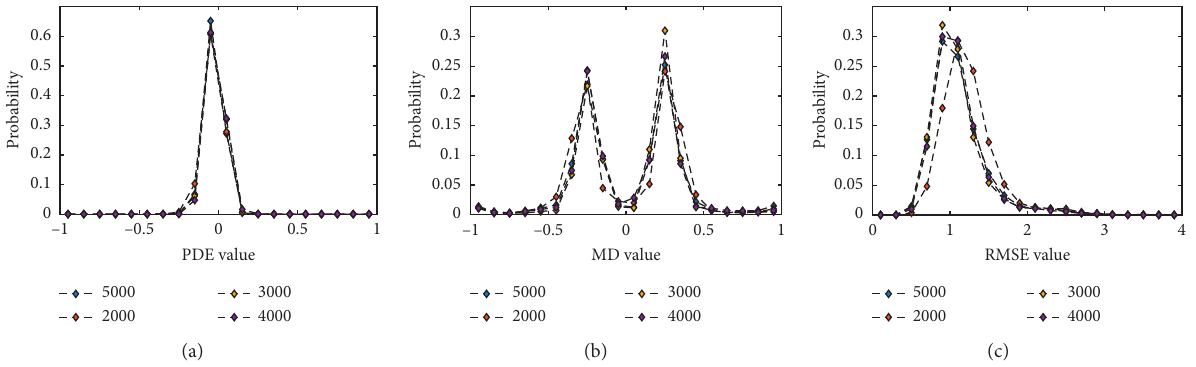
Figure 13: Error distribution of results from different size of training data sets. (a) PDE. (b) MD. (c) RMSE.